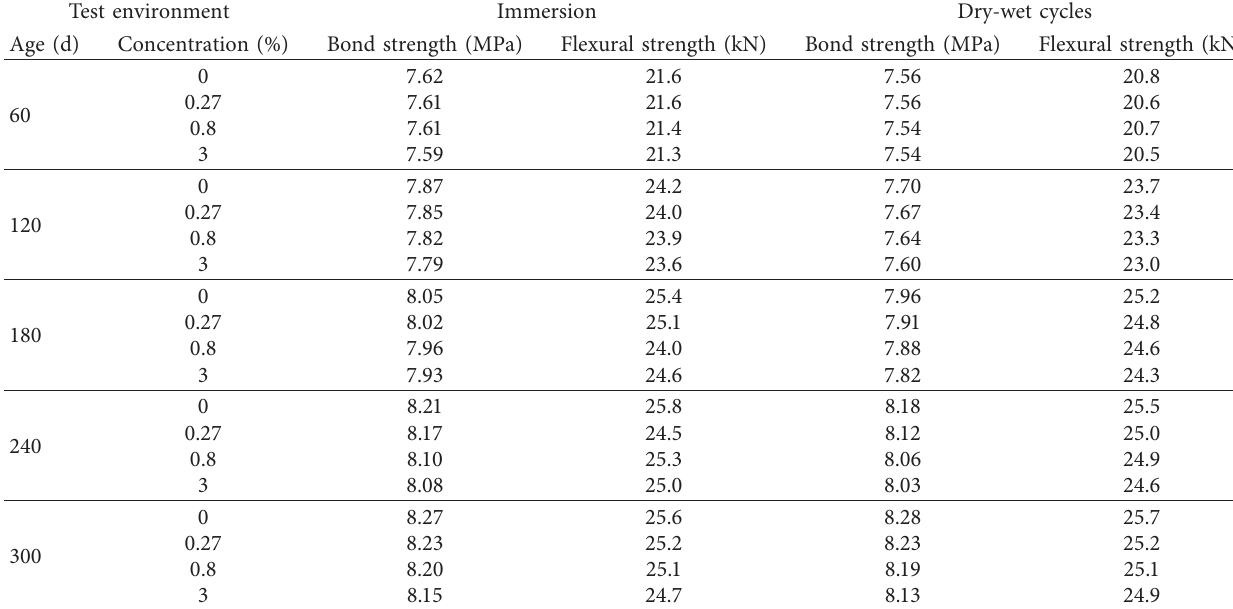
Table 5: Mechanical properties of reinforced